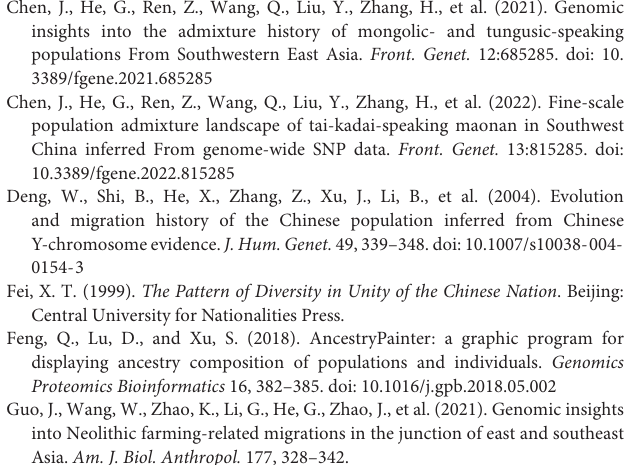
Supplementary Figure 1 | Geographical distribution of Guizhou Miao and Yao in this